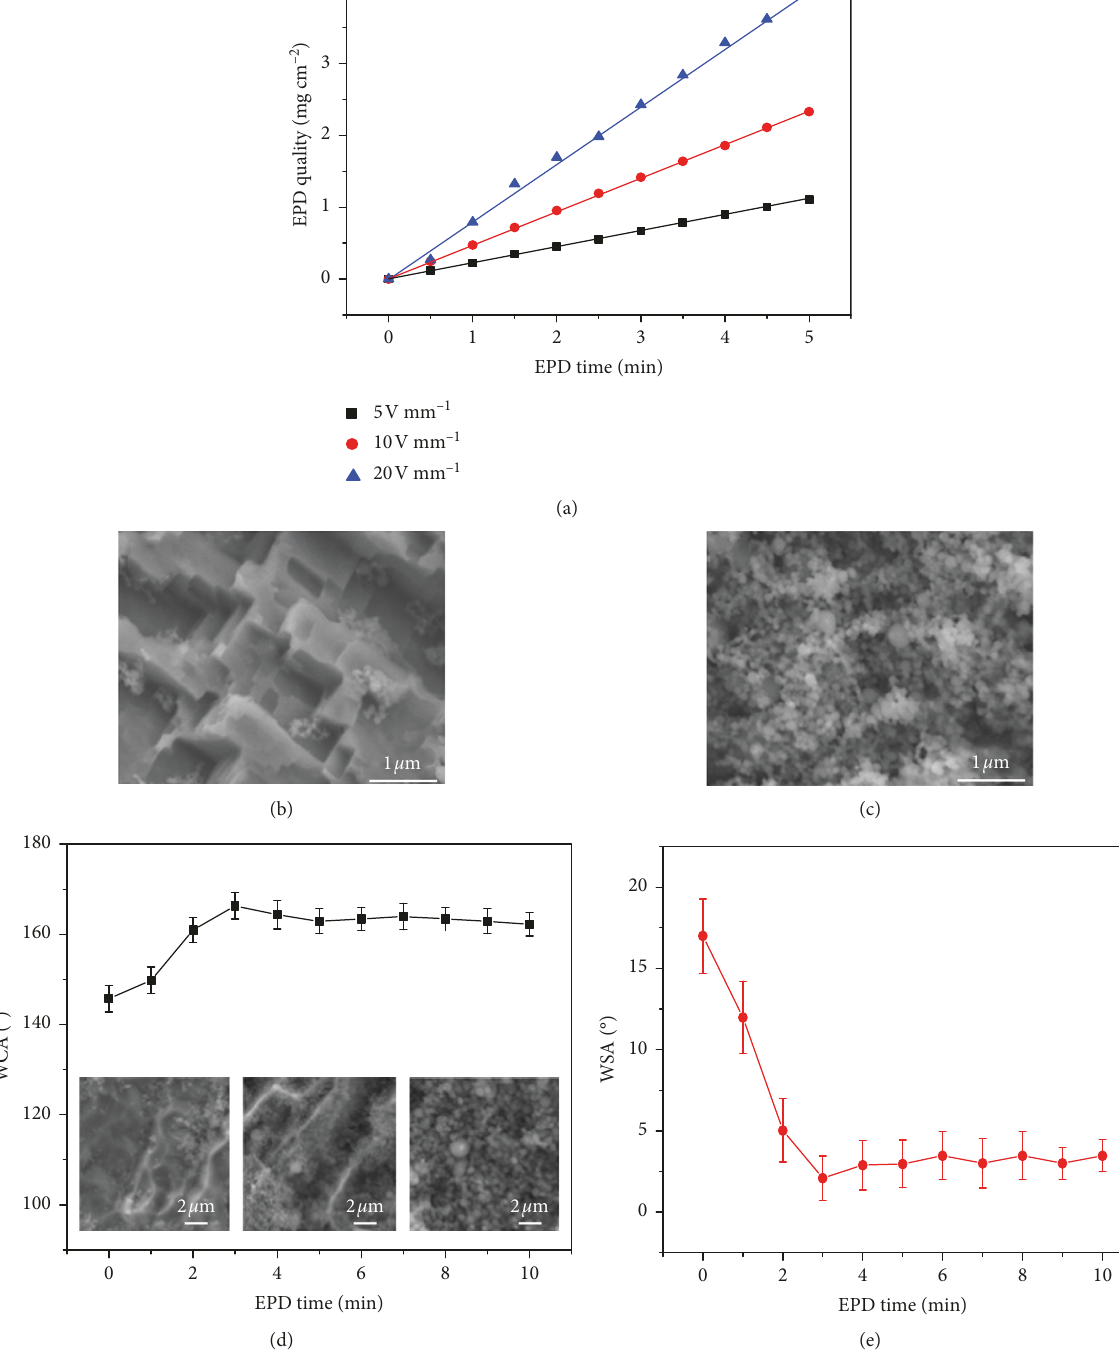
Figure 9: (a) The relationship of EPD time and deposited weight per cm − 2 of Al nanoparticles on etched Al alloy, FESEM of surface after (b) 1min and (c) 5min EPD time on etched Al alloy surface. Change is the (d) contact angle and (e) sliding angle of the brine on etched stainless steel as a function of the EPD time after STA